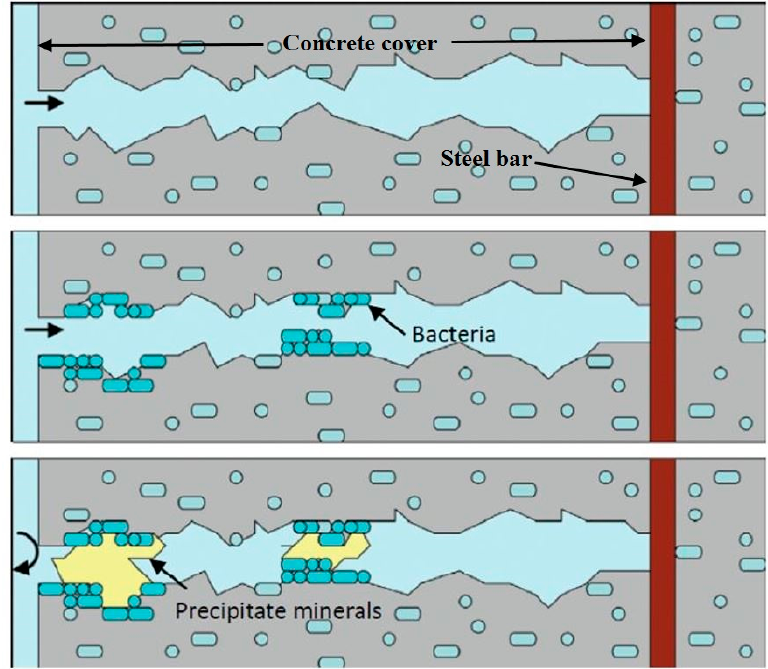
Figure 7. Typical crack-healing processes via immobilized bacteria in concretes [59] .